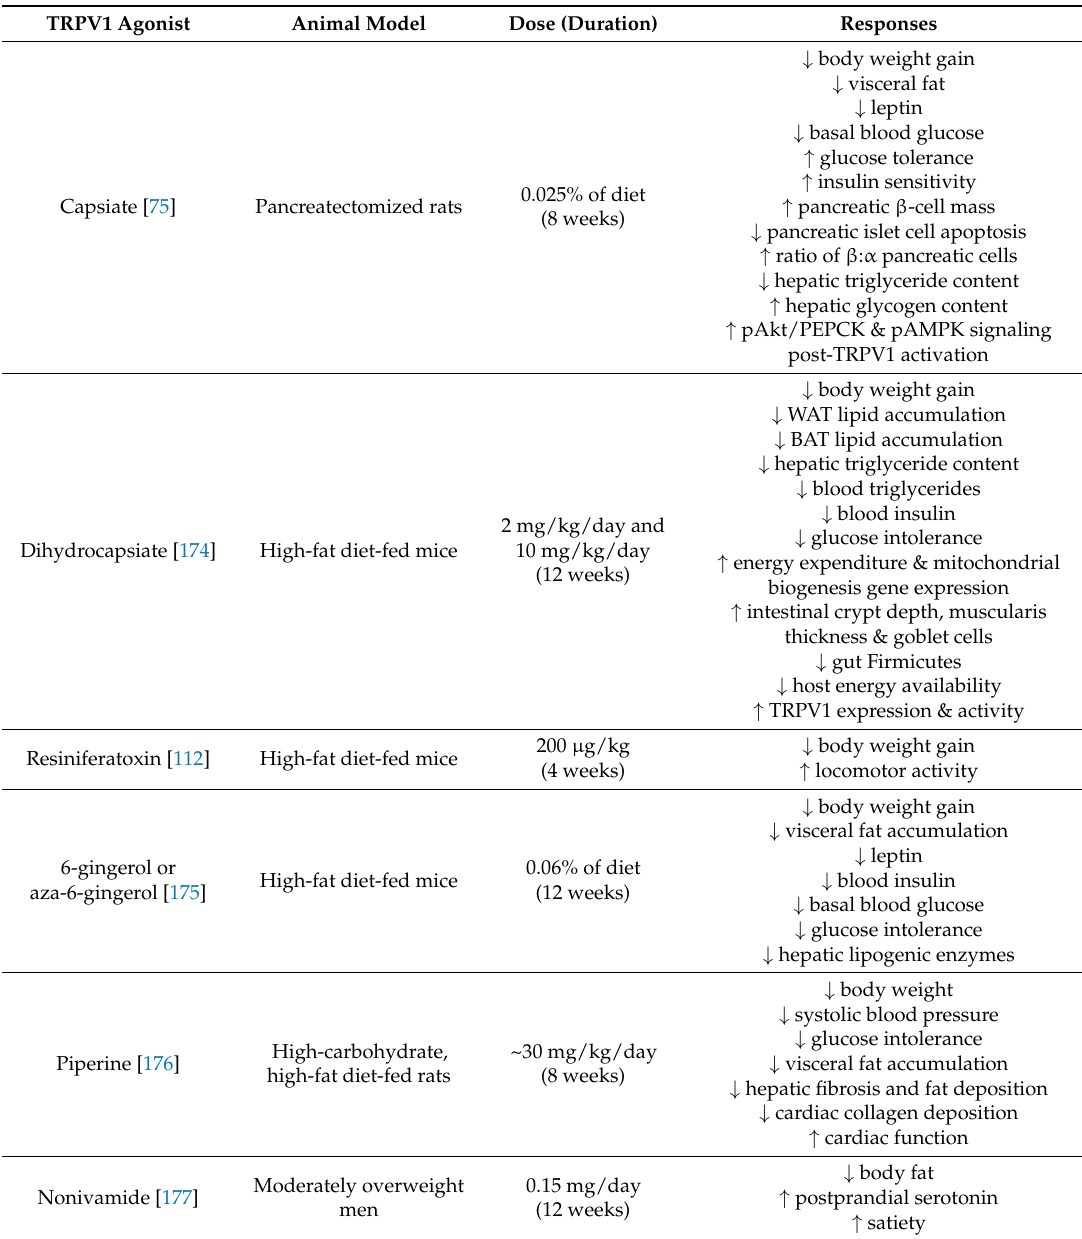
Table 2. A summary of studies demonstrating the effects of other TRPV1 agonists on obesity and obesity-related disorders in animal models and